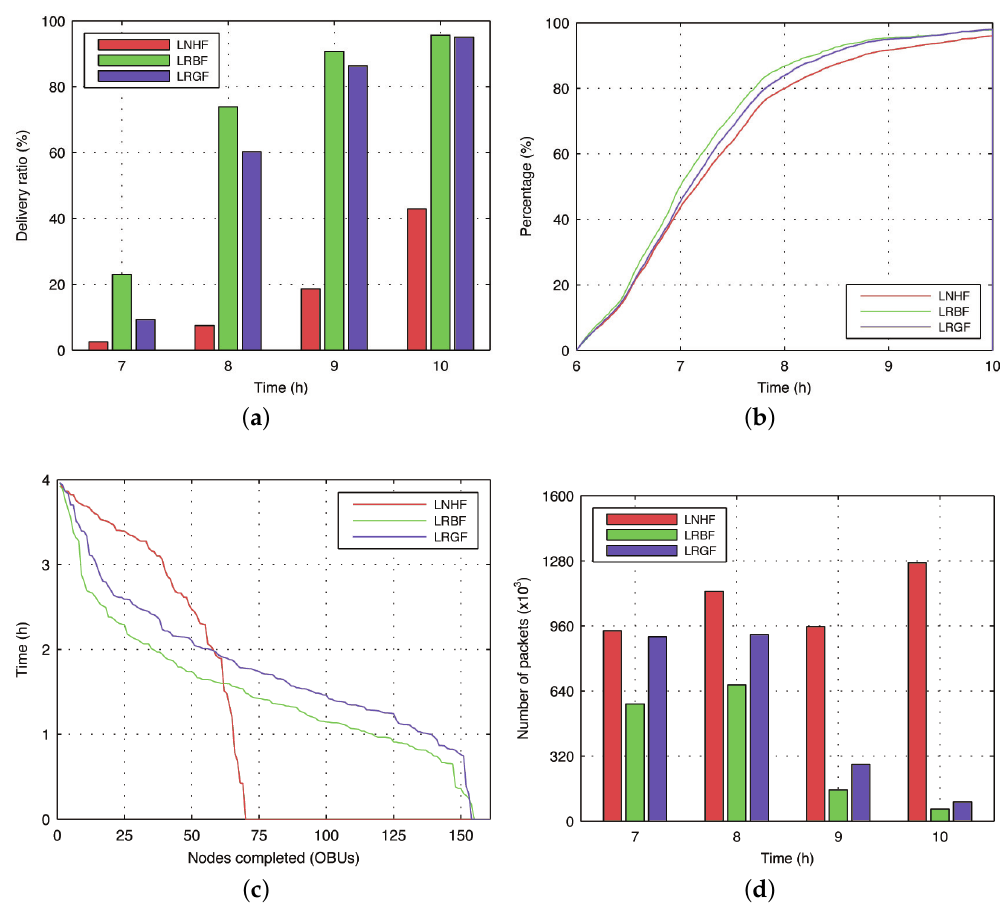
Figure 12. Performance of LNHF, LRBF and LRGF strategies for the Rush Hour period in City Center. ( a ) Delivery rate; ( b ) Percentage of file distribution; ( c ) E2E delay; ( d ) Number of listened